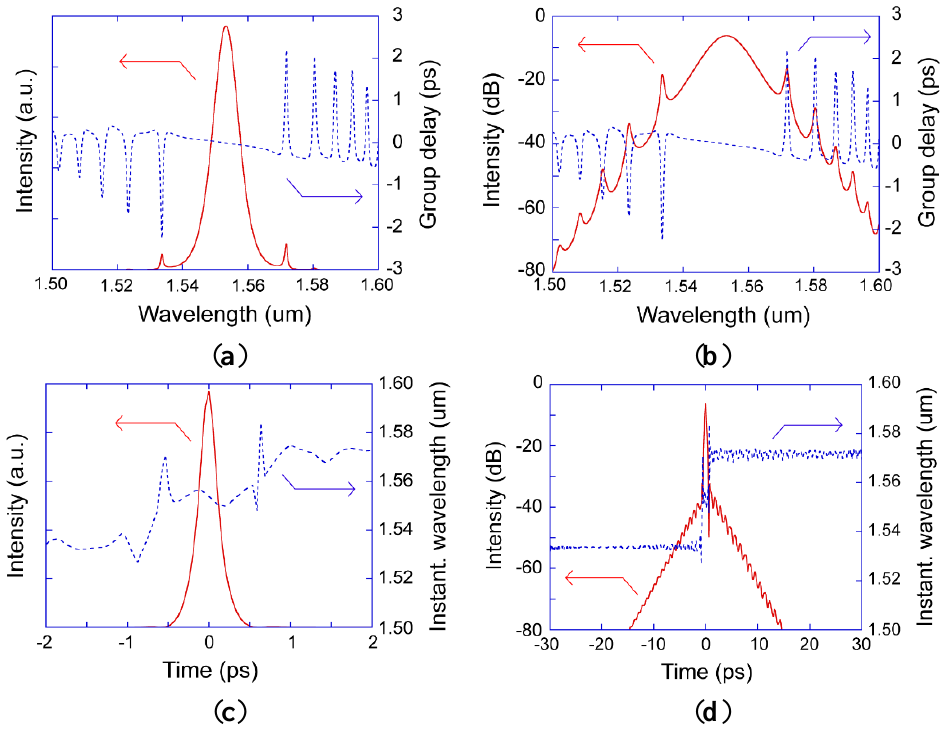
Figure 4. Characteristics of output pulse for soliton mode-locking regime without wavelength filter. ( a , b ) Spectral shapes on linear and log scales. ( c , d ) Temporal shapes on linear and log scales. Variations of spectral and temporal shapes of output pulse for initial mode-locking process are shown as movies in Media 1 and